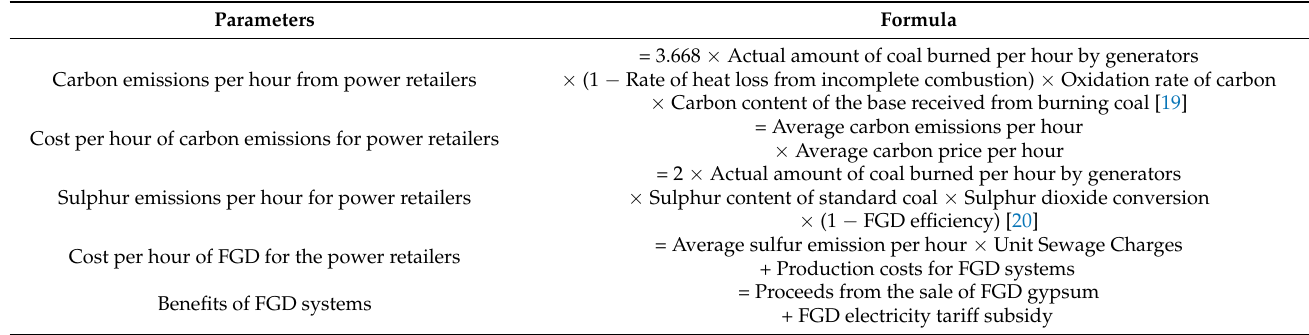
Figure 5. Stock flow diagram of costs and benefits of desulphurization and carbon emissions. Table 2. Cost–benefit mathematical model for desulphurization and carbon emissions.